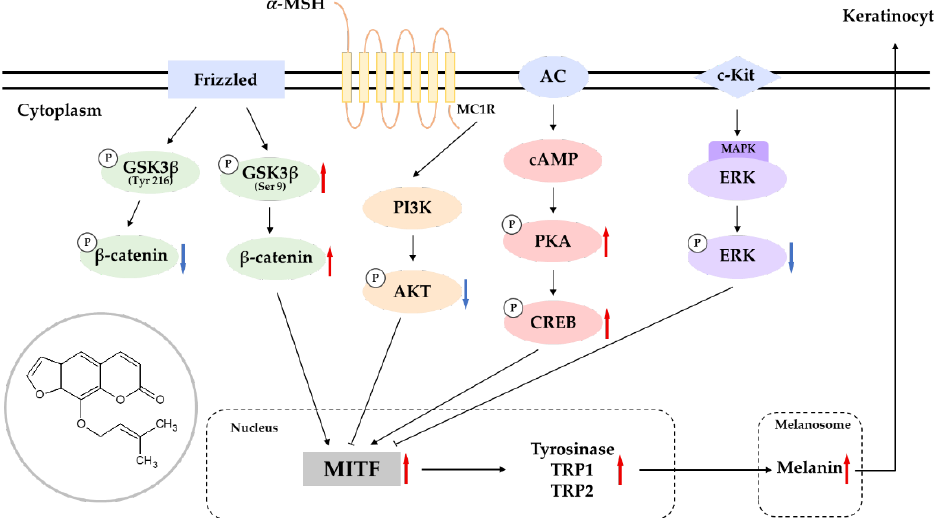
Figure 10. Schematic diagram of the proposed mechanism regulating the stimulative action of imperatorin on melanogenesis.